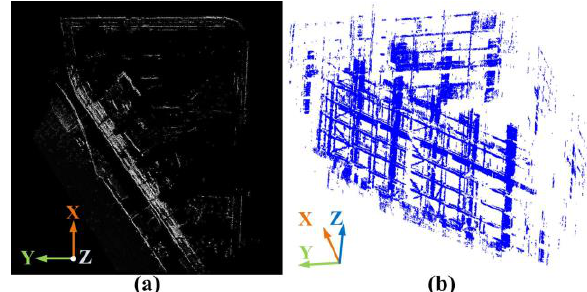
Figure 8. a) The projected counting image, b) the selected